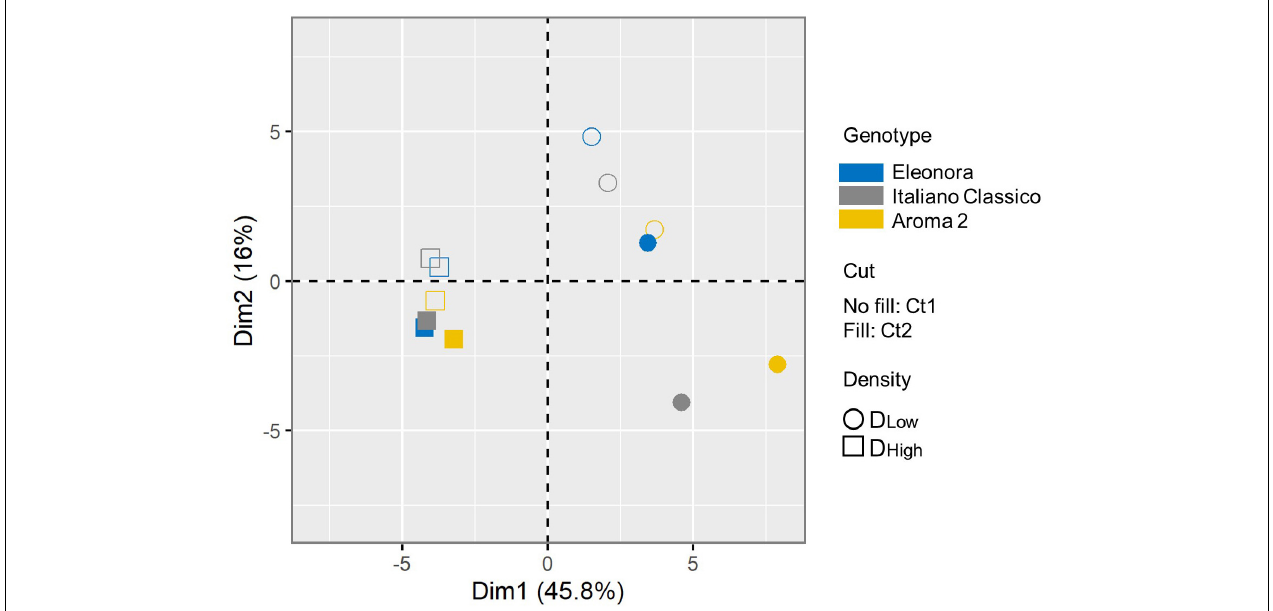
FIGURE 2 | Principal component analysis (PCA) of the basil response. Symbol shape indicates the growing density (D Low : circle; D High : square). Each condition is colored according to the variety (“Eleonora”: blue; “Italiano Classico”: gray; “Aroma 2”: gold). For each cut, the plot displays the symbol empty (CT1) or filled (CT2). The color and symbol legends are reported on the right